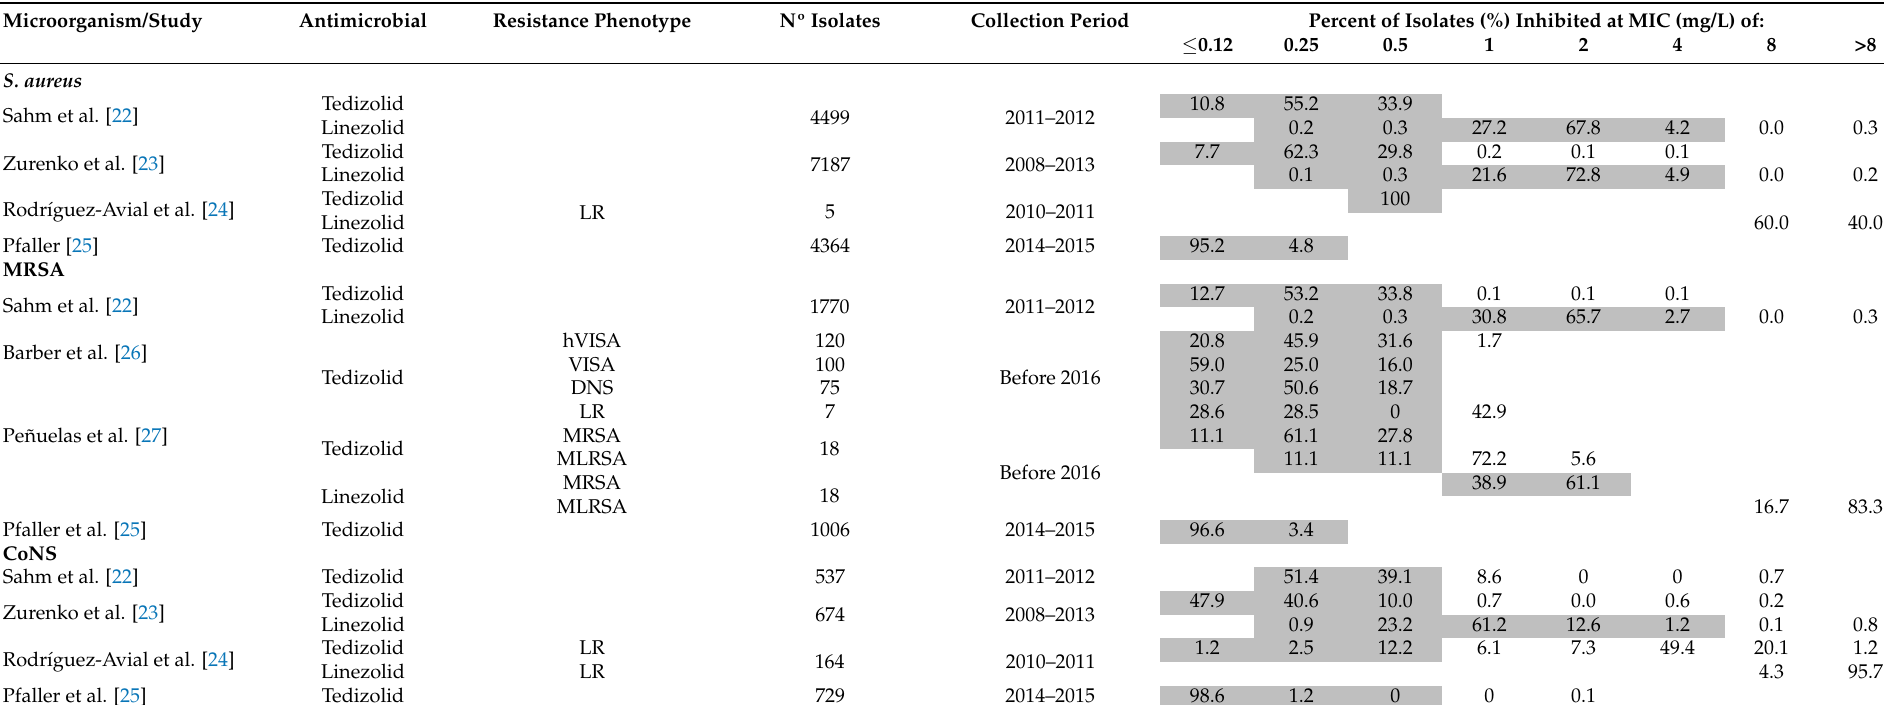
Table 2. Resistance phenotype, number of isolates, collection period, and antimicrobial activity of staphylococci for tedizolid and linezolid.